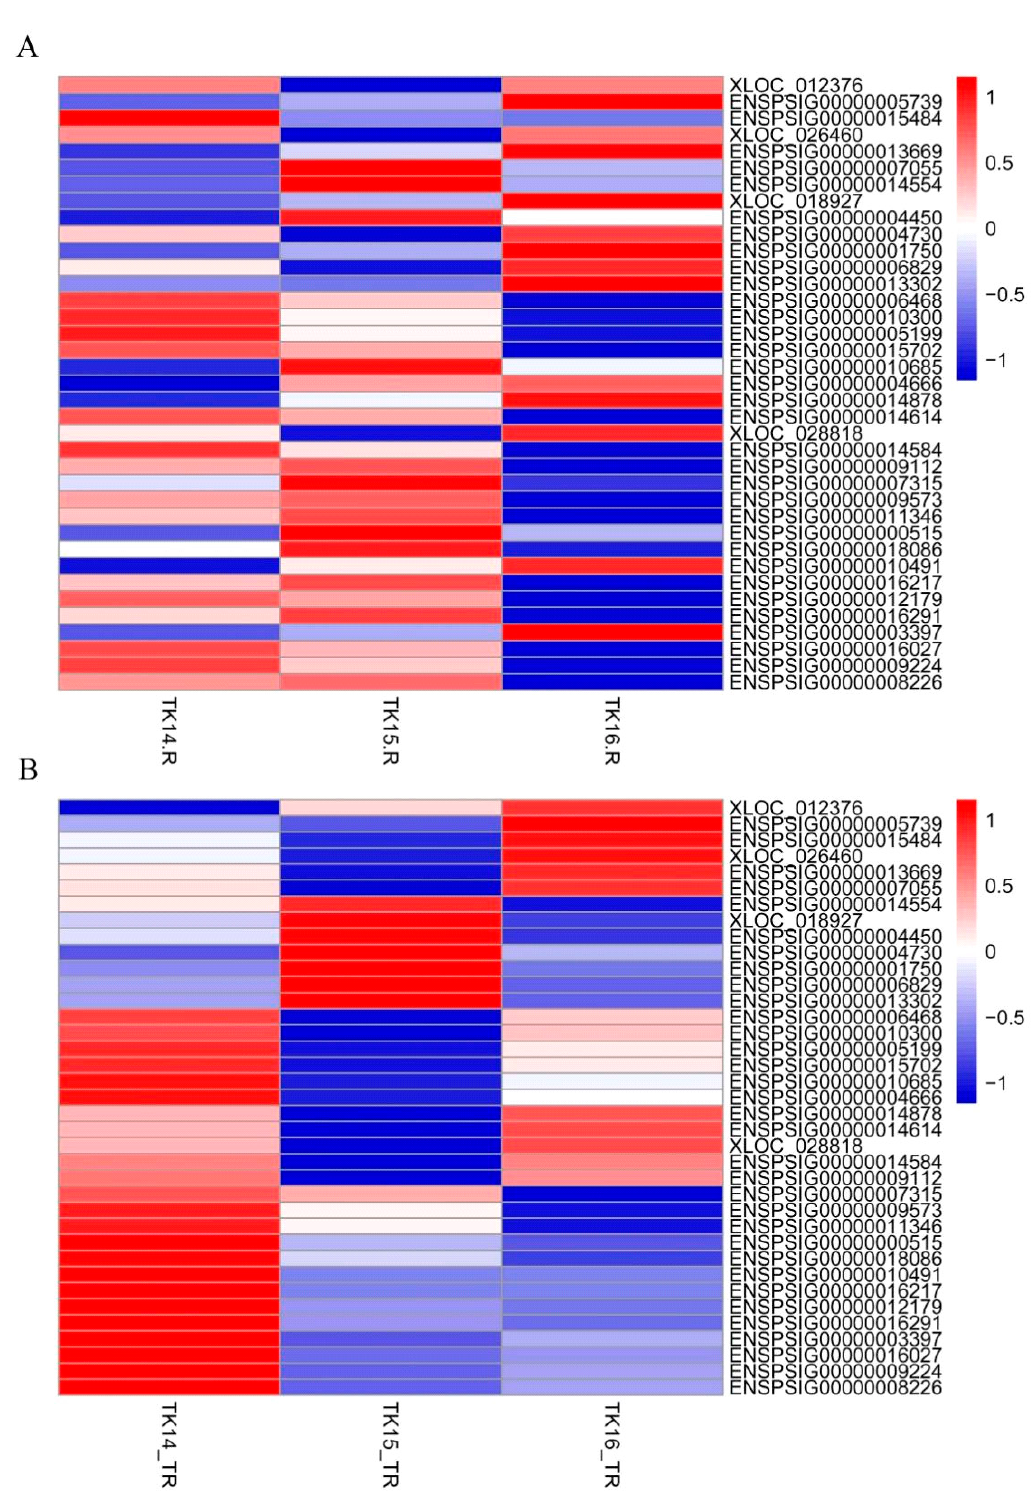
Figure 5. Heatmaps of Wnt members including the mRNA abundance and RNC-mRNA abundance. ( A ) Heatmaps of the mRNA abundance. ( B ) Heatmaps of the RNC-mRNA abundance. The data were depicted as a matrix, in which each row represents one mRNA/RNC-mRNA and each column represents one group. The relative mRNA expression and translated ratio of RNC-mRNA were depicted according the color scale shown on the right. Red represents high relative expression, and blue represents low relative expression; − 1, − 0.5, 0 and 0.5, 1 are fold changes in the corresponding spectrum. The magnitude of deviation from the median is represented by the color saturation.